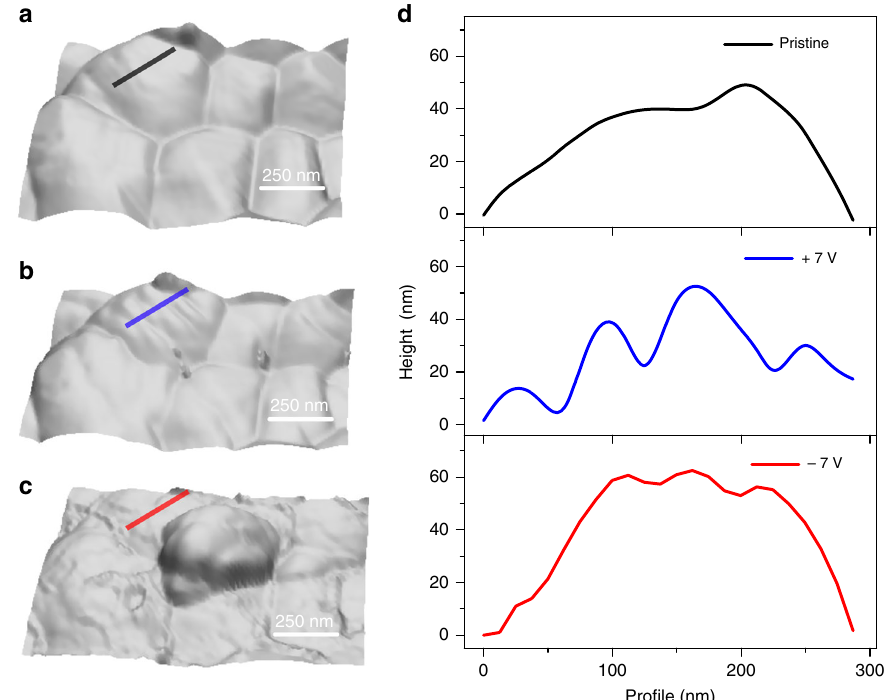
Fig. 4 Effect of bias on structural variation of the surface. a 3D topography in non-contact mode in the dark, b after positive bias, + 7 V, and c after negative bias − 7 V. d Line pro fi les for the black, blue, and red regions in a –